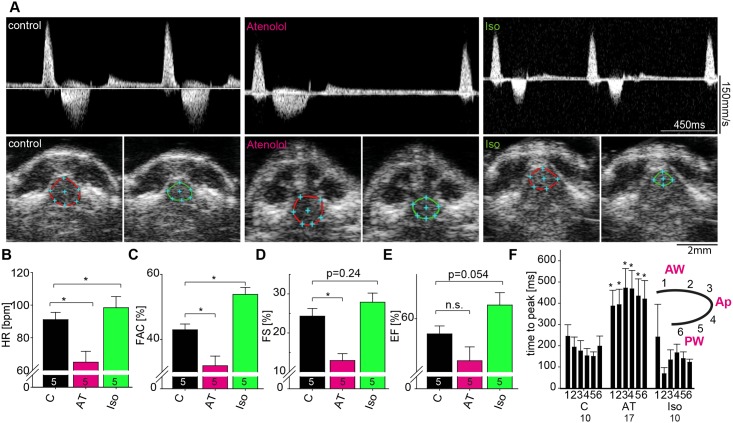
Changes in cardiac performance in response to beta-adrenergic stimulation and blockage.(A) Representative pulsed-wave Doppler (PWD) signals (upper row) acquired from ACX view illustrating reduced and elevated heart rate in Atenolol (middle, AT) and Isoproterenol (right, Iso) treated zebrafish, respectively, compared to controls (left). Representative SAX images (lower row) with demarcated end-diastolic (red) and end-systolic (green) ventricular dimension after Atenolol and Iso treatment. (B-E) Quantification of changes in heart rate (HR) (B), fractional area change (FAC) (C), fractional shortening (FS) (D), and ejection fraction (EF) (E) after AT or Iso treatment compared to controls (C). Small numbers in columns indicate number of animals measured. (F) For speckle-tracking analysis, the ventricle was divided in six segments as indicated with segment 1 and 2 representing the anterior wall, 3 and 4 the apex, and 5 and 6 the posterior wall. Time-to-peak analysis reveals that AT leads to significantly prolonged time-to-peak indices in myocardial velocity of all segments. Small numbers in columns indicate number of animals measured. Values are expressed as mean ± SEM. Ap, Apex; AT, Atenolol; AW, anterior wall; Iso, Isoproterenol; PW, posterior wall; *, p<0.05; unpaired student’s t-test.